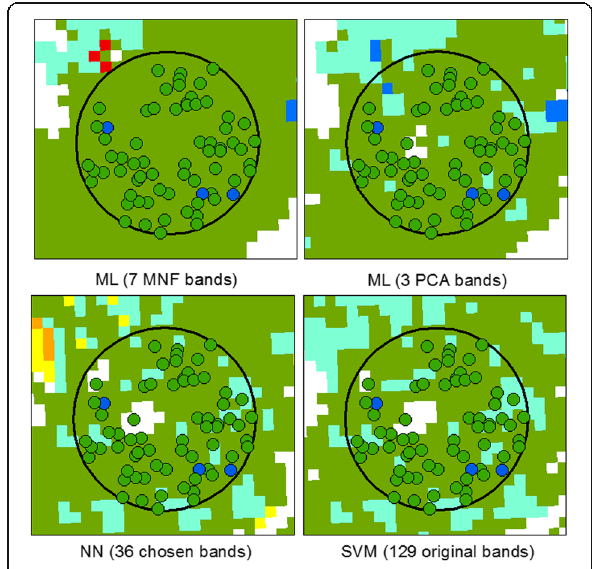
Fig. 4 Comparison of the results of four classification techniques (SVM-129, NN-36, ML-PCA, ML-MNF) on a single sample plot (Adams et al. 1995). Legend: red — birch, orange — European beech, yellow — oak, pink — hornbeam, pale blue — European larch, green — Scots pine, dark blue — Norway spruce